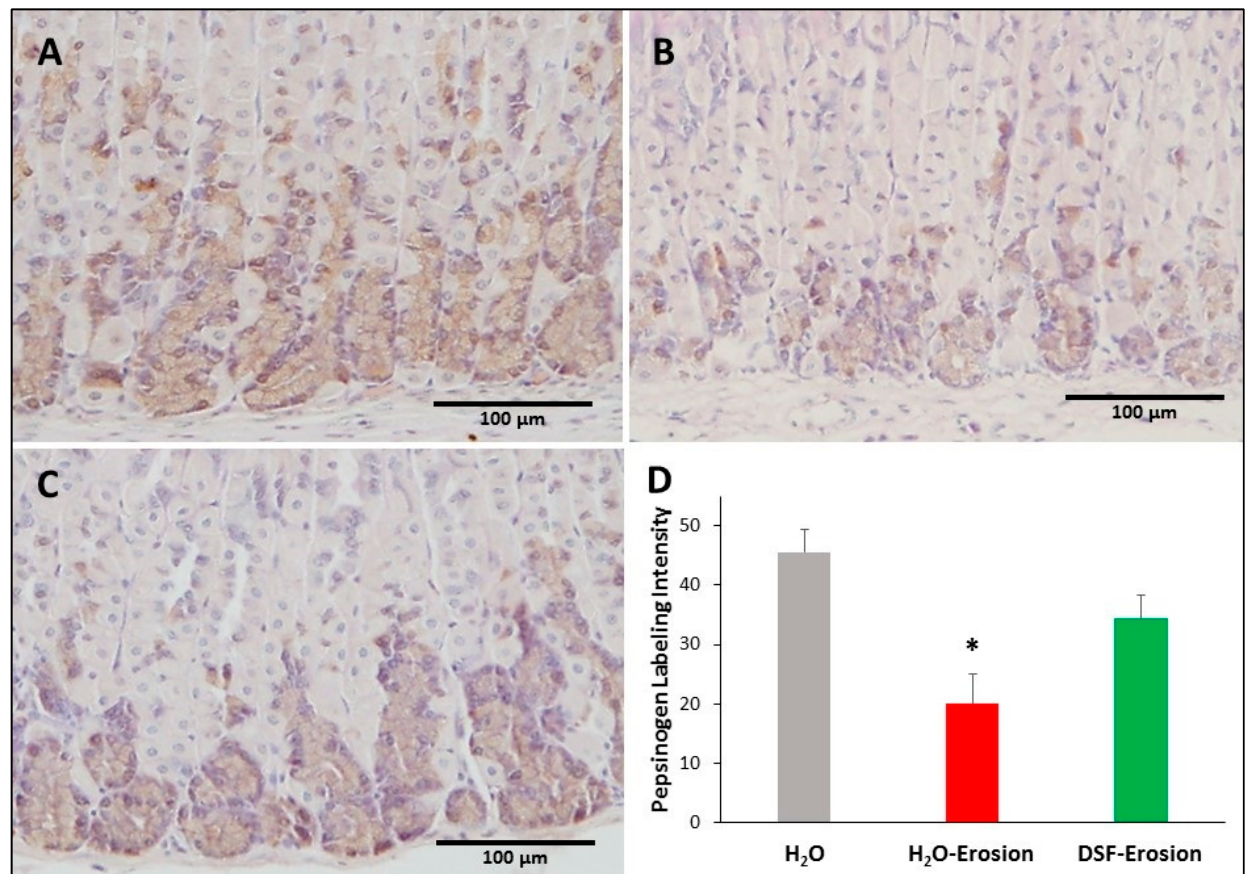
Figure 9. Pepsinogen immunolabeling in the gastric mucosae of H 2 O control ( A ), erosion-induced ( B ) and DSF-erosion ( C ) mice. The tissue sections were counterstained with hematoxylin. Brownish pepsinogen-labeled cells are seen in the basal regions of the gastric mucosae. Labeled cells are more prominent in control and DSF-pretreated tissues than in erosion-induced tissues. ( D ) Quantification of pepsinogen labeling intensity (or percentage of labeled pixels in equivalent areas) of the mucosa of three mice in each group is presented as mean ± SE. * p < 0.05; scale bar = 100 µm.